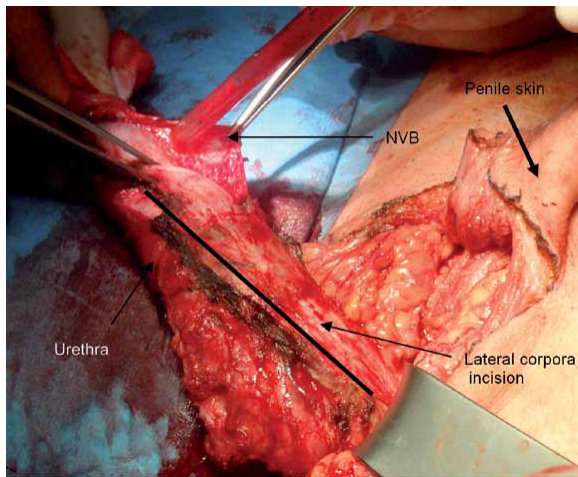
Figure 2 – Lateral incisions along Buck’s fascia reaching the base of the penis and exposure of neuro-vascular-bundle (NvB).